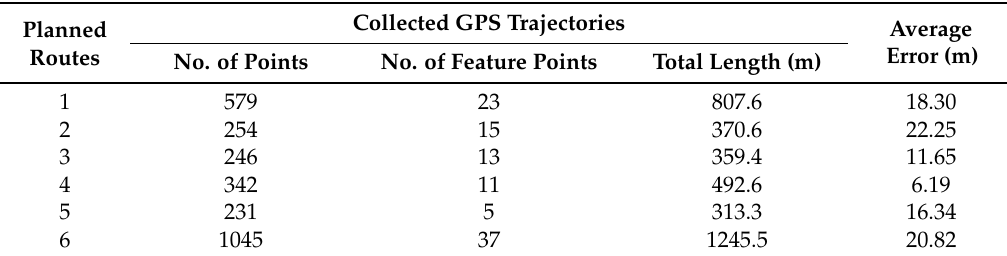
Figure 10. Six planned routes (thick parts from the background PND) and collected GPS trajectories along the routes (small circles). Table 3. Planned routes and collected GPS trajectories. Average errors were calculated from the recorded accuracy values of GPS points.